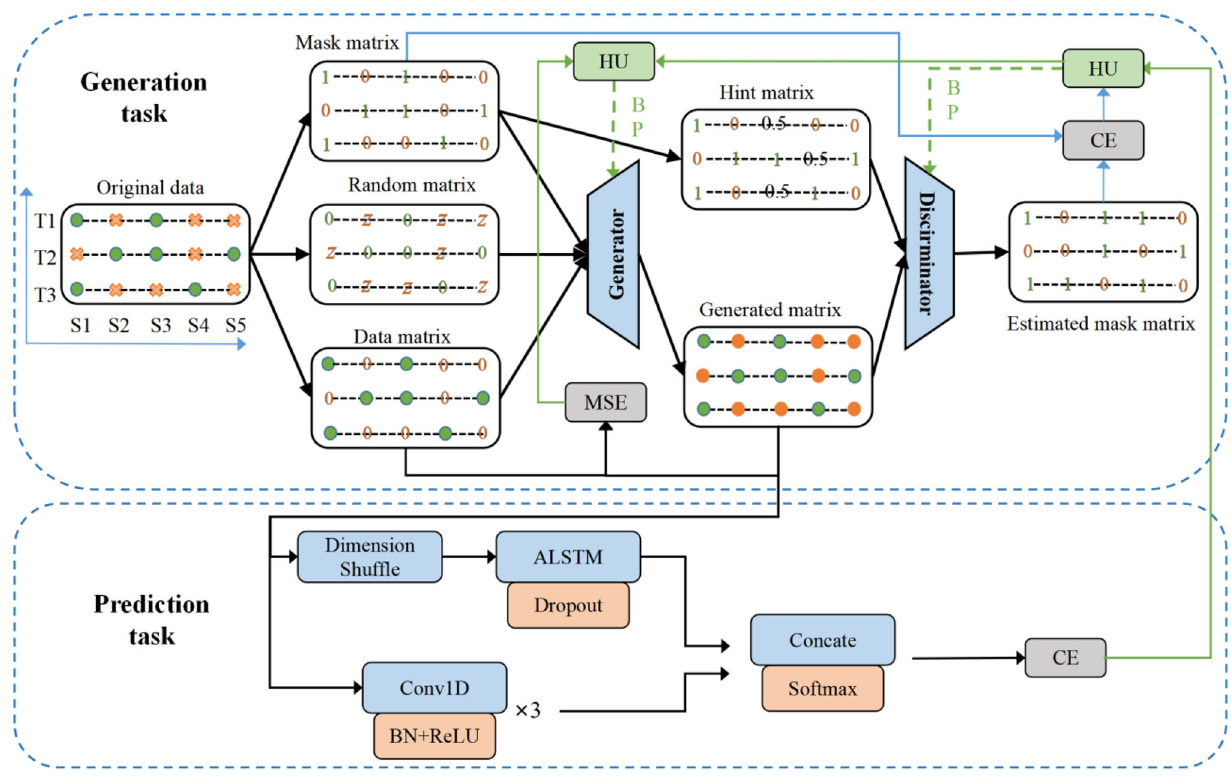
Fig. 2 The architecture of